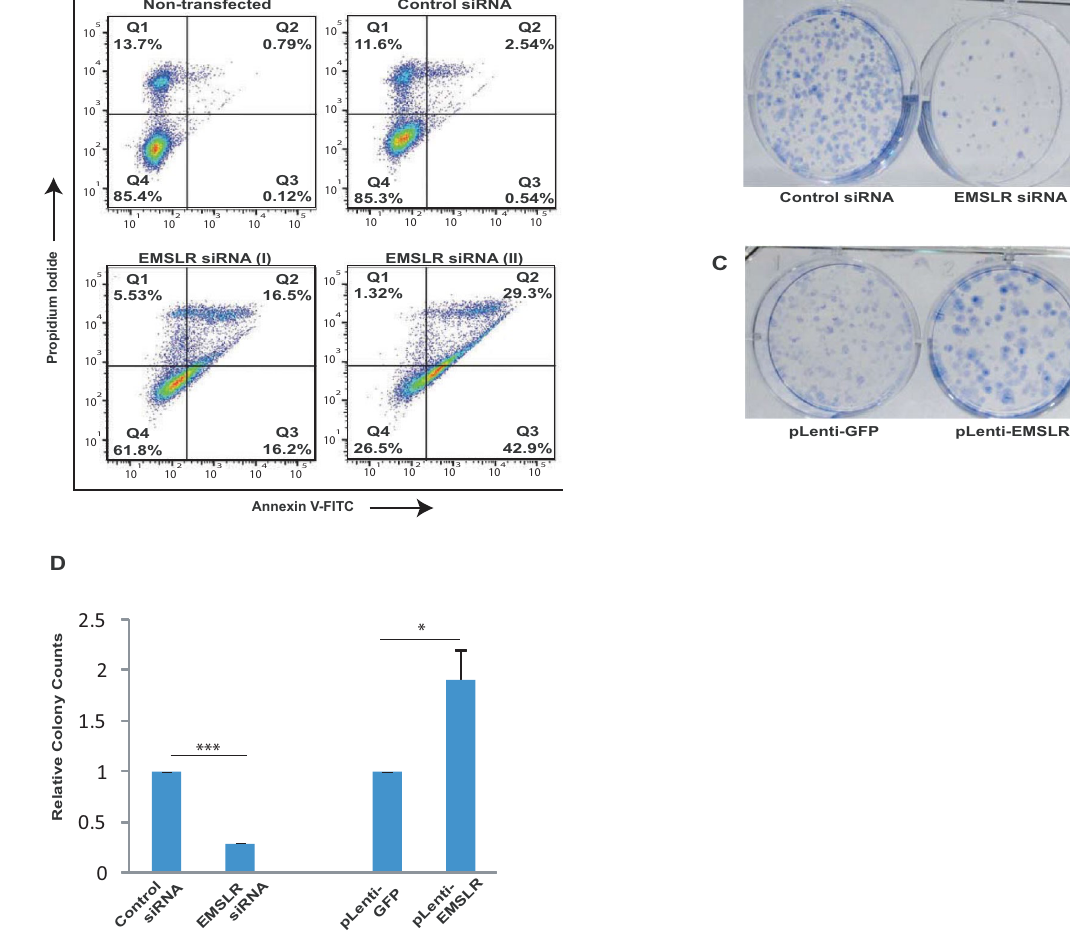
Figure 3. EMSLR depletion inhibits the tumor-related phenotypes of LUAD cells. ( A ) Depletion of EMSLR induces cell death in A549 cells. Flow cytometry of control GL2 or EMSLR -depleted A549 cells, obtained by transfecting EMSLR siRNA (I) or siRNA (II), stained with FITC-conjugated anti-Annexin V antibody along with propidium iodide. Dot plot displays PI (y-axis) and Annexin V (x-axis) incorporation. Criteria were set to distinguish between viable (bottom left), early apoptotic (bottom right) and late apoptotic (top right) cells. ( B – D ) Clonogenic assay to evaluate the effect of EMSLR manipulation on A549 cells. (B) EMSLR siRNA (I)-depleted A549 cells as described in Fig. 2B were allowed to grow for 12 days, stained with crystal violet and the colonies were counted. ( C ) A549 cells were infected with lentivirus expressing EMSLR and grown for 12 days, followed by staining with crystal violet and the colonies were counted. Quantification of parts ( B ) and ( C ) is shown in part ( D ) . The data is represented as mean of two independent experiments ± S.D. p values were calculated using two-tailed t-test (* p < 0.05; ** p < 0.01, *** p <